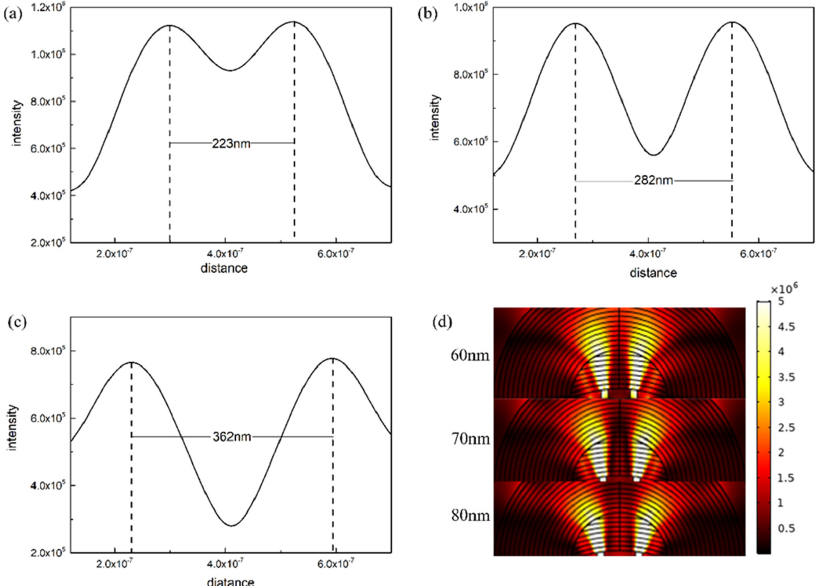
Figure 4. ( a ) Schematic diagram of different detecting distances. ( b ) Intensity distribution detected with different distances. Red line, dark blue line and blue dashed line represent 300 nm, 100 nm, and 50 nm detecting distance, respectively.